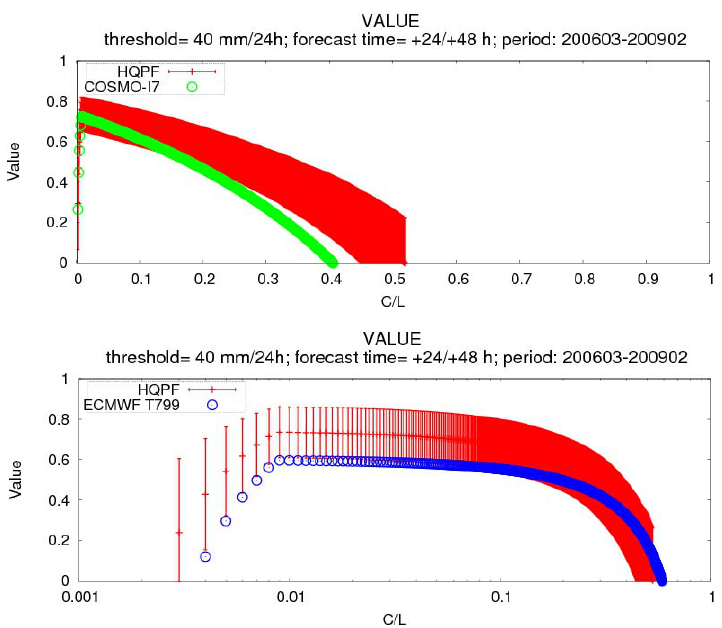
Fig. 3. Comparison between the Value of HQPF and, respectively, COSMO-I7 (top) and IFS (bottom), for the 40mm/24h threshold and different C/L ratios, considering QPFA and the forecast time +24h/+48h. Note that the x-axis of the bottom plot is in logarithmic scale. The plotted error bars indicate 2.5th and 97.5th percentiles of a resampled distribution for the difference itself.